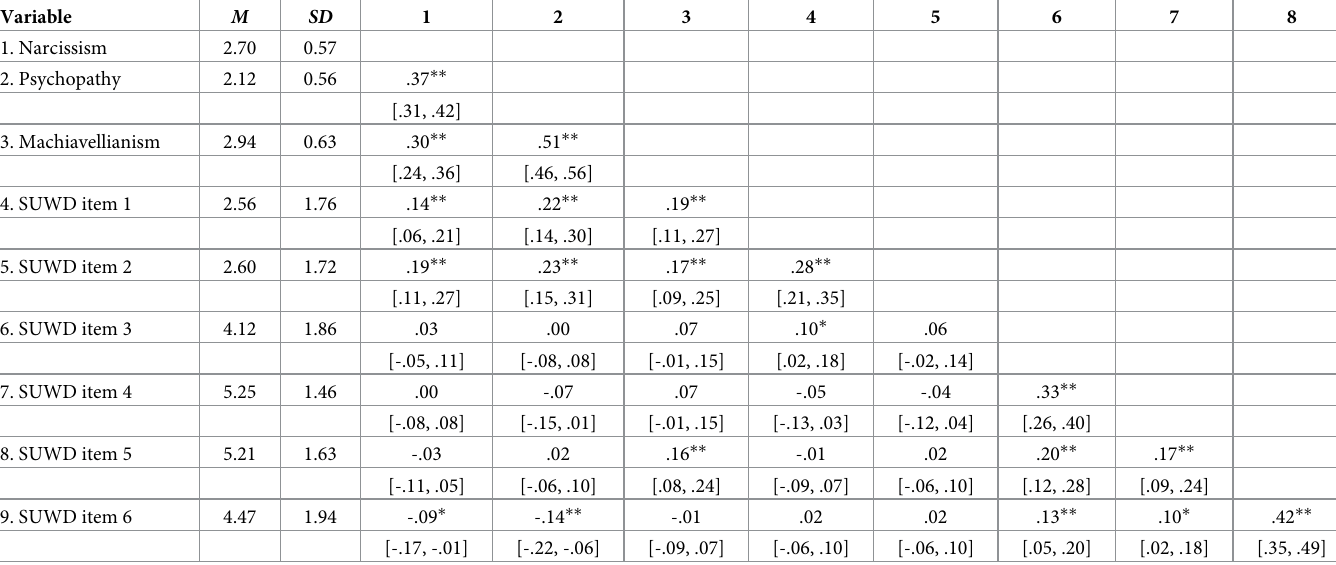
Note . M and SD are used to represent mean and standard deviation, respectively. Values in square brackets indicate the 95% confidence interval for each correlation. The confidence interval is a plausible range of population correlations that could have caused the sample correlation [63]. * indicates p < .05.